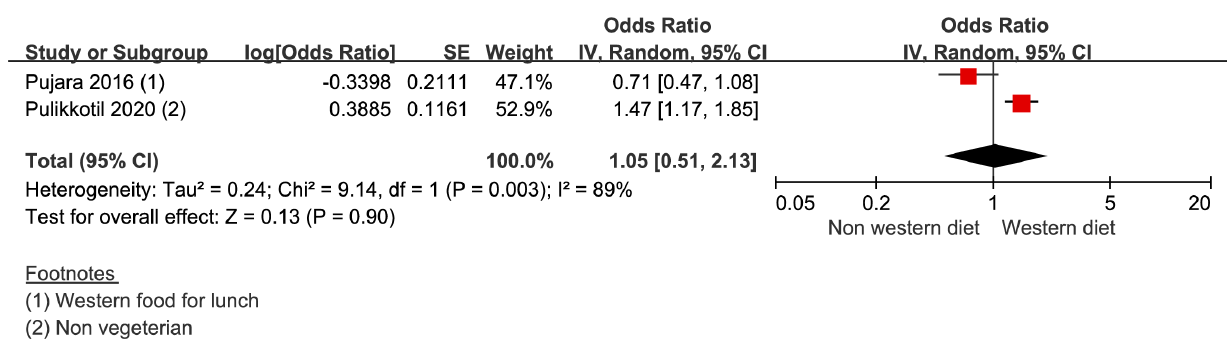
Figure 2. Risk of periodontal disease with the western diet [24,25]. -red color: weight for overall effect; -black color: 95% confidence interval